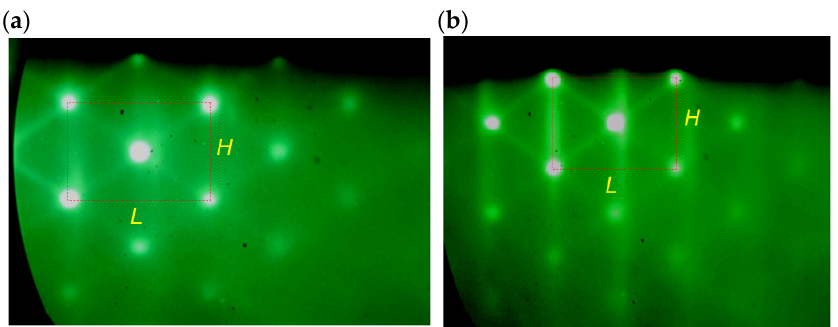
Figure 2. RHEED patterns obtained after the SAQDs formation in the HS of ( a ) type B grown at T s = 420 ° С and in the HS of ( b ) type D grown at T s = 450 ° С . Thin red dotted lines mark the sizes L and H .